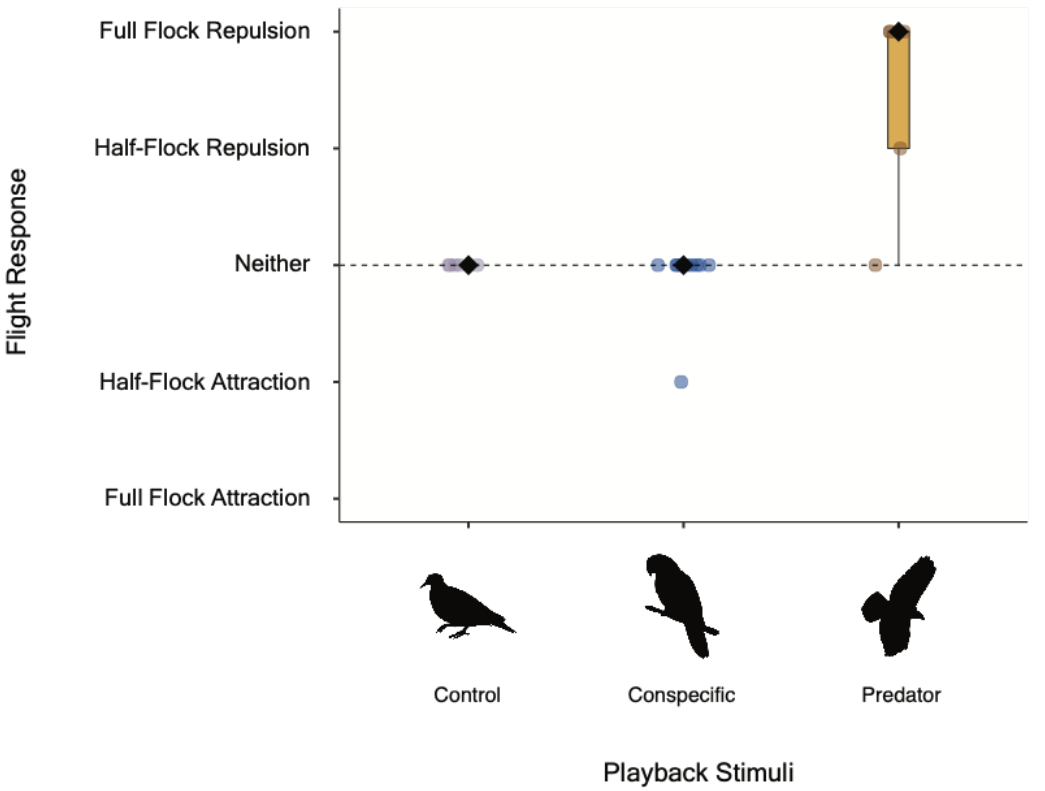
Monk Parakeet Repulsion and Attraction Behavior in Response to Playback